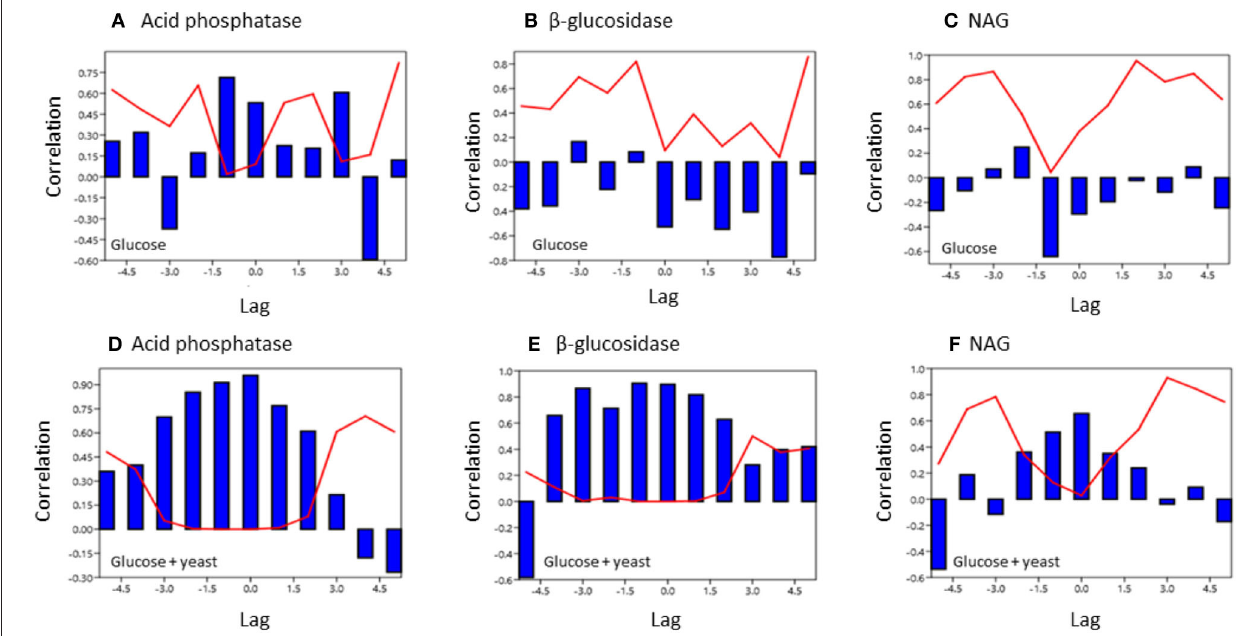
FIGURE 7 | Cross covariance function of enzyme activities during microbial growth was computed between the two soils of contrasting nutrient content. The x-axis shows the lag in hours and y-axis the correlation coefficient. The red line denotes the level of significance ( P < 0.05) at a specific lag. (A,D) acid phosphatase, (B,E) beta-glucosidase; (C,F)